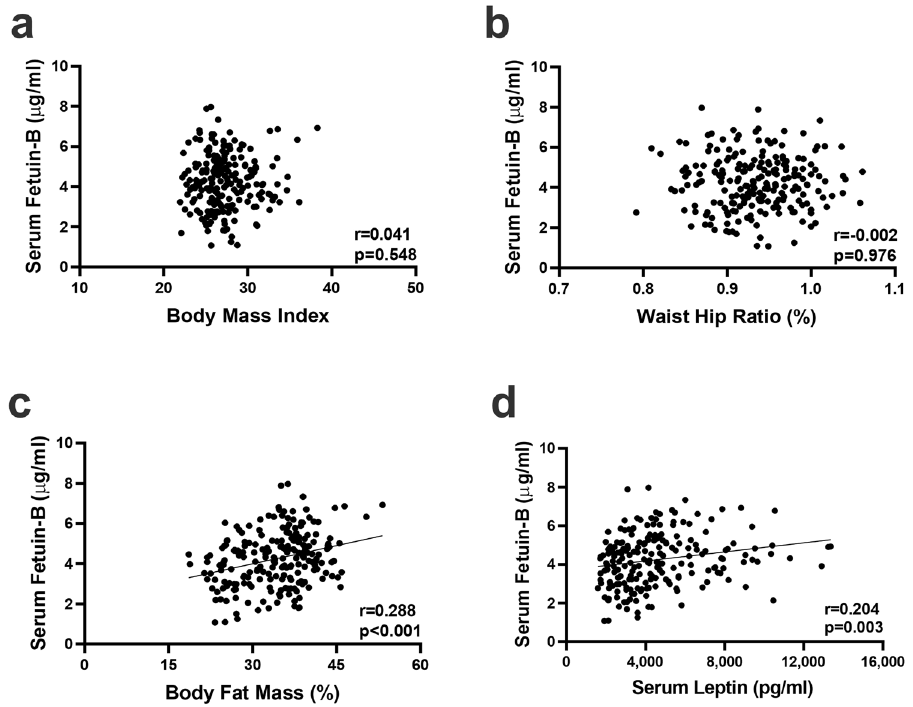
Figure 1. Correlations between serum Fetuin B and obesity indices and serum leptin in obese adults. The correlations between serum Fetuin B and the body mass index (BMI) ( a ), waist–hip ratio (WHR) ( b ), body fat mass (BFM) ( c ) and serum leptin ( d ) were assessed in 215 obese Chinese adults (n = 215). Pearson correlation coefficient was applied for correlation analysis. P values < 0.05 were considered statistically